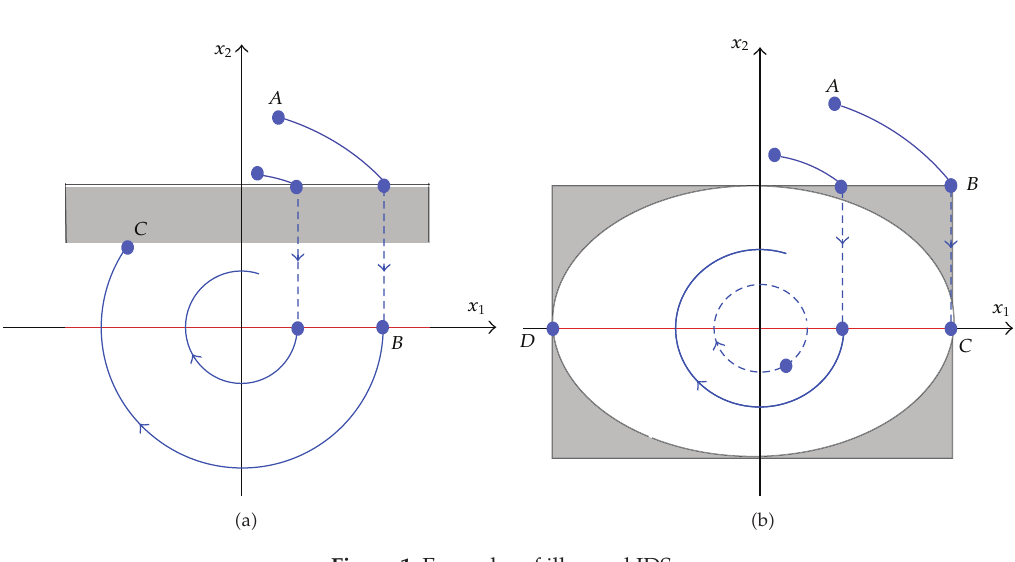
Figure 1: Examples of ill-posed